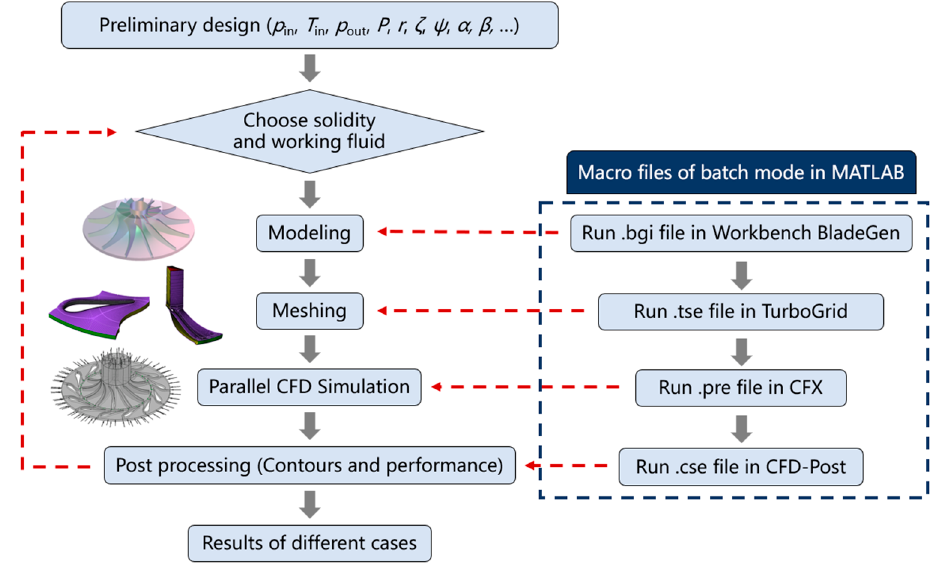
Figure 1. Flow chart of design and simulation.